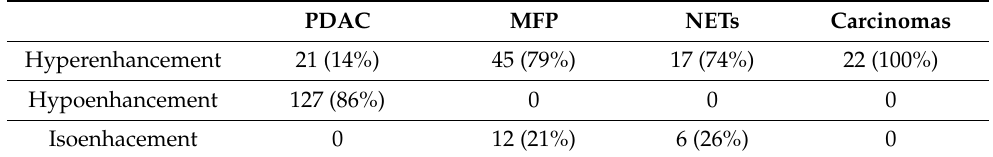
Table 6. Contrast enhancement patterns of the main pancreatic lesions. Values are number of pa- tients (%).